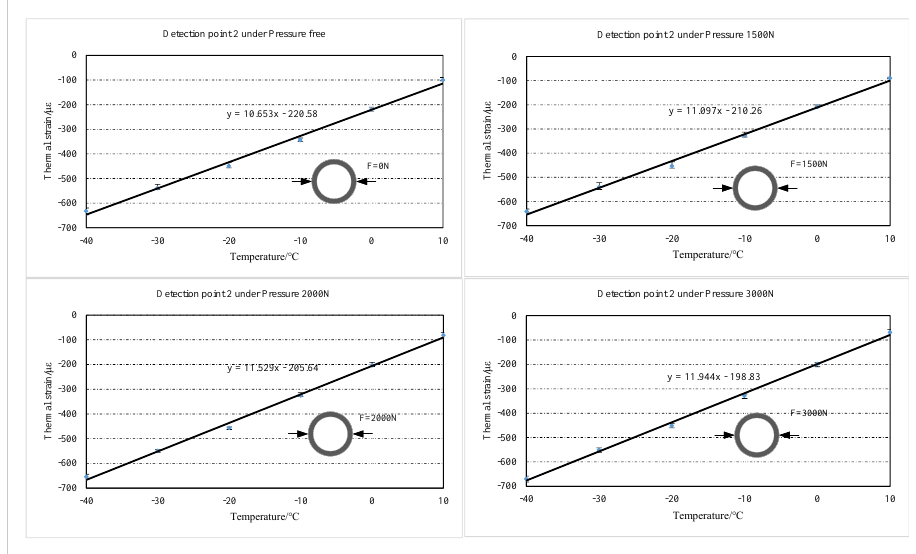
Figure 10. Error bar of the thermal strain in detection point 2 under each stress condition. The thermal strains of two test points under 3000 N radial pressure are taken for analysis. When the temperature of the two detection points is reduced to 10 ◦ C, the thermal strains at the two detection points under 3000 N radial pressure decrease by 30.9% and 30.65%, respectively, compared to the free thermal strains. The results indicate that stress restraint has a significant inhibitory effect on the cold shrinkage of concrete structures. When the temperature decreases to near − 20 ◦ C, the free thermal strain of concrete and the thermal strain under different stress constraints start to close. This result indicates that the degree of cold shrinkage inhibition of concrete by tensile stress gradually decreases with the enhancement of thermal